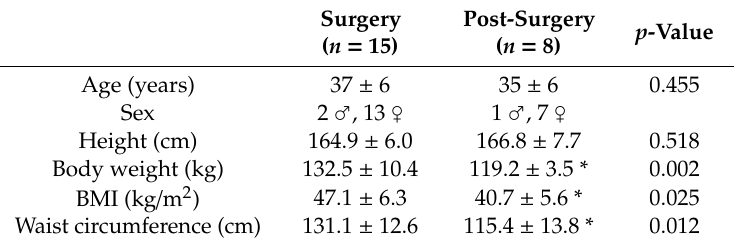
Table 1. Physical characteristics of study participants at the time of surgery ( n = 15) and three months post-surgery ( n = 8).